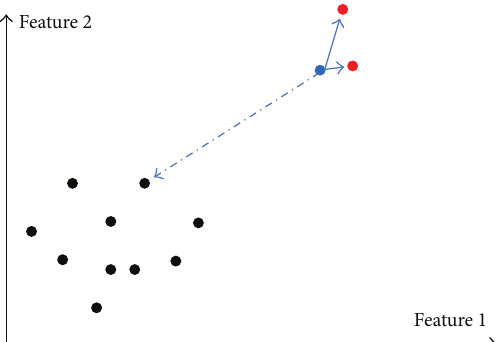
Figure 3: The effect of 𝐾 value on abnormal node’s 𝐾 -distance function (𝐾 = 𝑚2 = 3) .